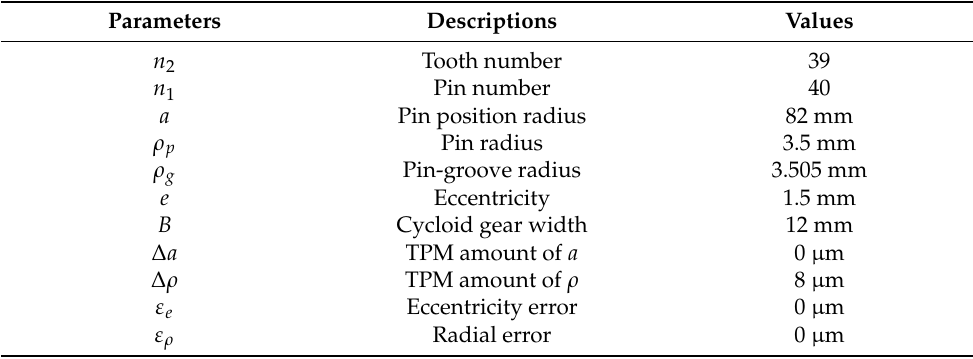
Table 1. Major design parameters for the example cycloid-pin gear pair.